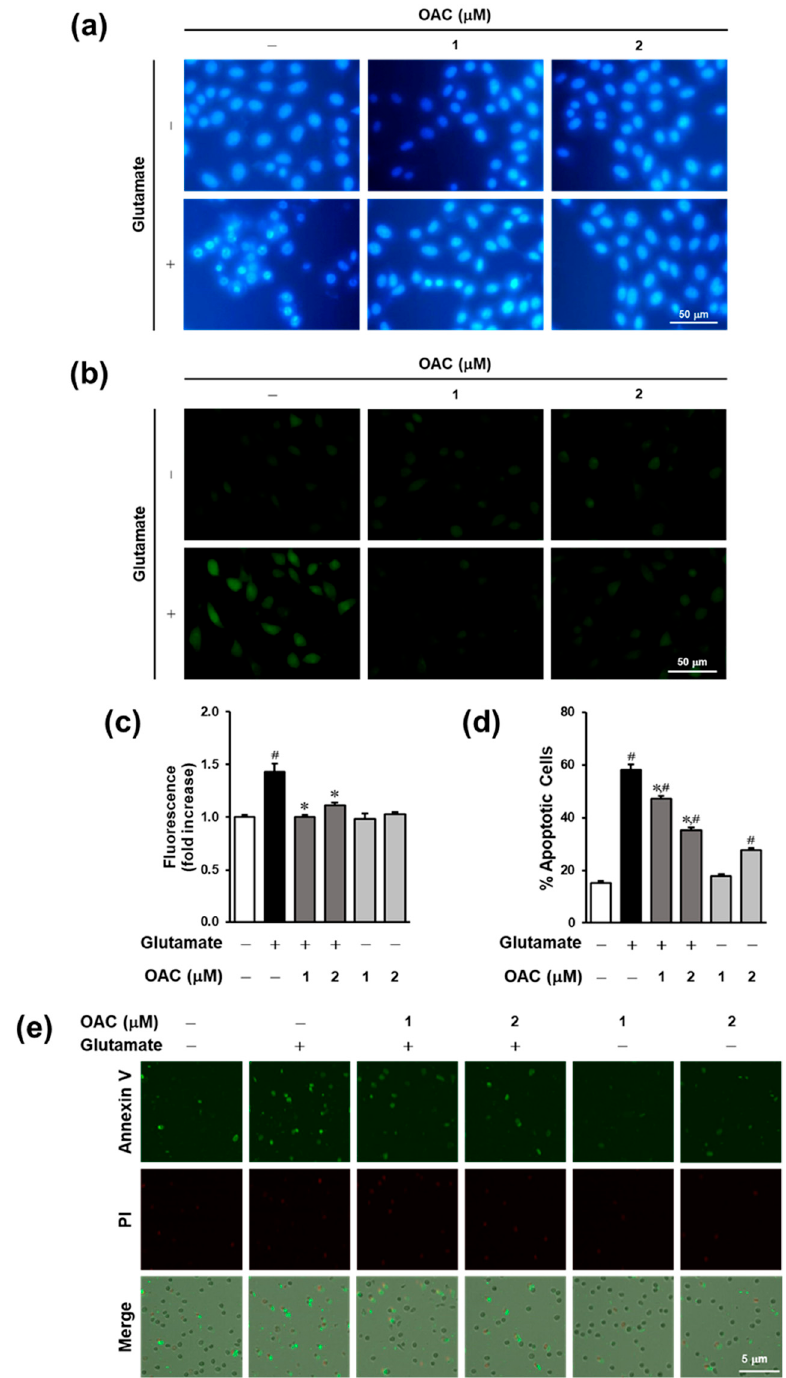
Figure 3. Anti-apoptotic effect of OAC against glutamate-induced neuronal cell death. ( a ) OAC prevented chromatin condensation in HT22 cells treated with glutamate. ( b ) Fluorescent images of fluo-4 staining. ( c ) OAC reduced the accumulation of intracellular calcium induced by glutamate in HT22 cells ( ∗ p < 0.005 vs. glutamate-treated group; # p < 0.005 vs. non-treated group). ( d ) The comparative graph illustrates the percentage of apoptotic cells ( ∗ p < 0.001 vs. glutamate-treated group; # p < 0.001 vs. non-treated group). ( e ) The microscopic images from an image-based apoptosis assay. OAC: osmundacetone; PI: propidium